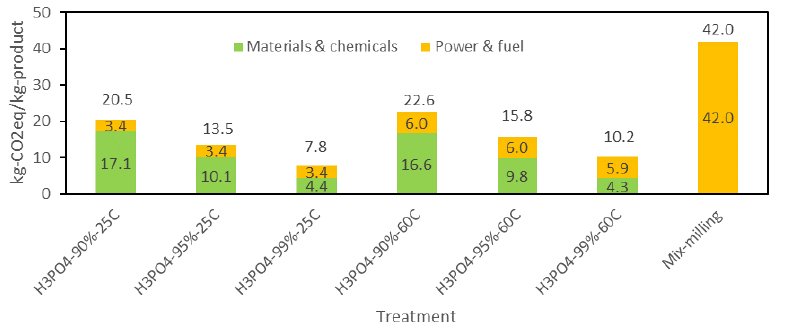
Figure 10. CO 2 emissions per kg of glucose produced after hydrolysis of cellulose pretreated with H 3 PO 4 -assisted adsorption method and mix-milling method. Hydrolysis conditions: cellulose + AC-Air mixture, 40 mL water, 180 °C, 20 min.